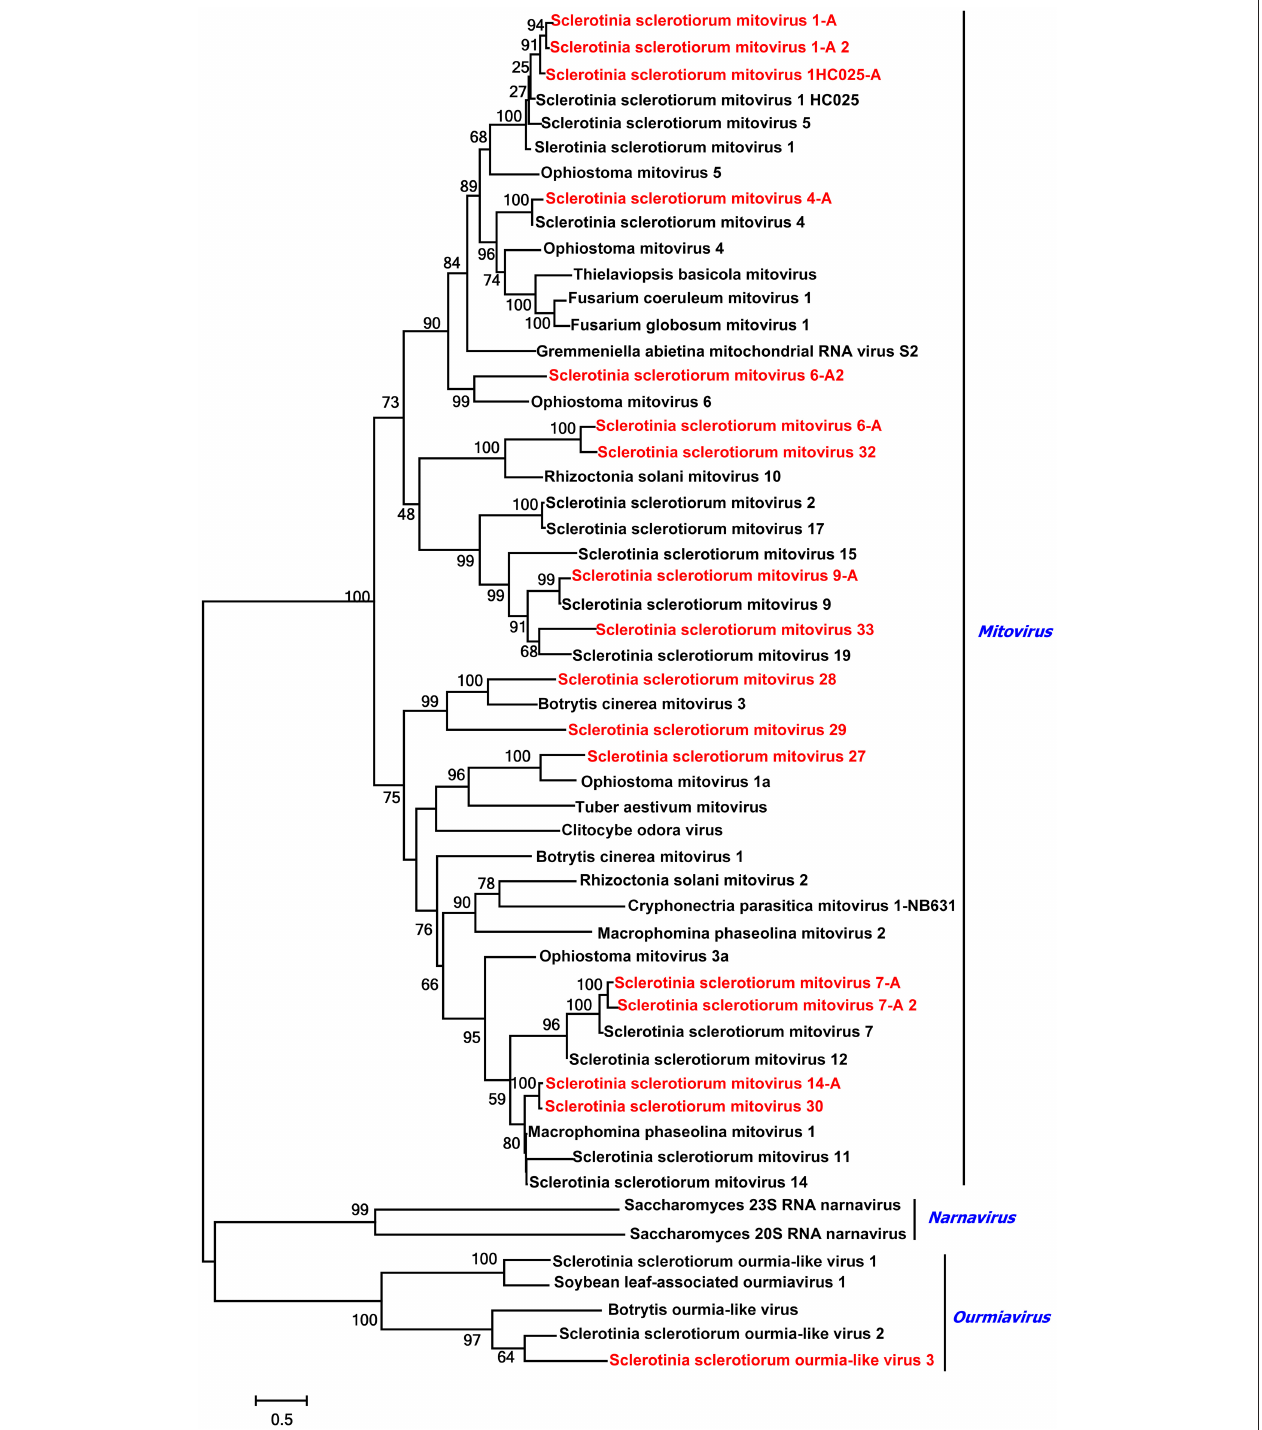
FIGURE 6 | Phylogenetic analysis of Mitoviruses and Ourmiavirus . Phylogenetic relationships of mitoviruses and ourmiavirus that infect Sclerotinia sclerotiorum and other selected viruses. Multi alignments are based on the virus’s full-length RdRp amino acid sequences. Viruses marked with red color are found in Australian isolates of Sclerotinia sclerotiorum